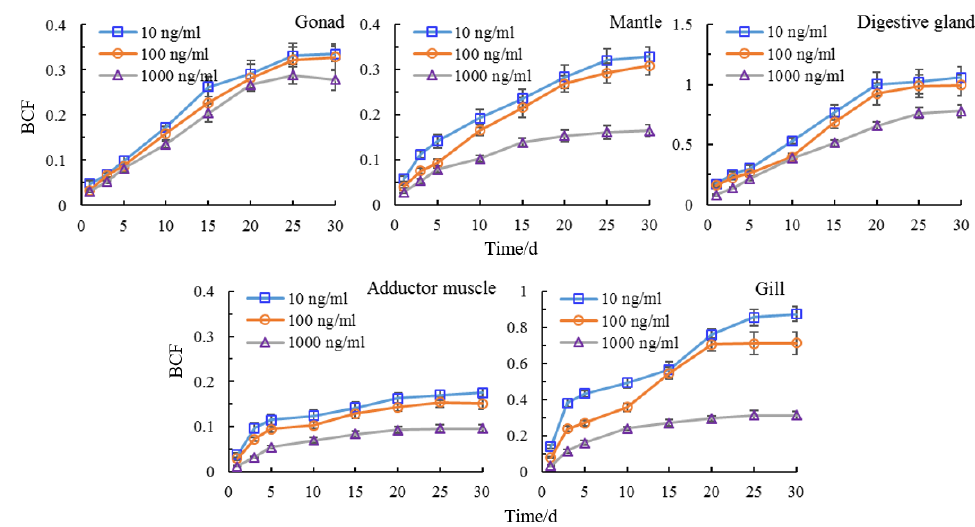
Figure 6. BCF of tissue-bound semicarbazide in scallop .